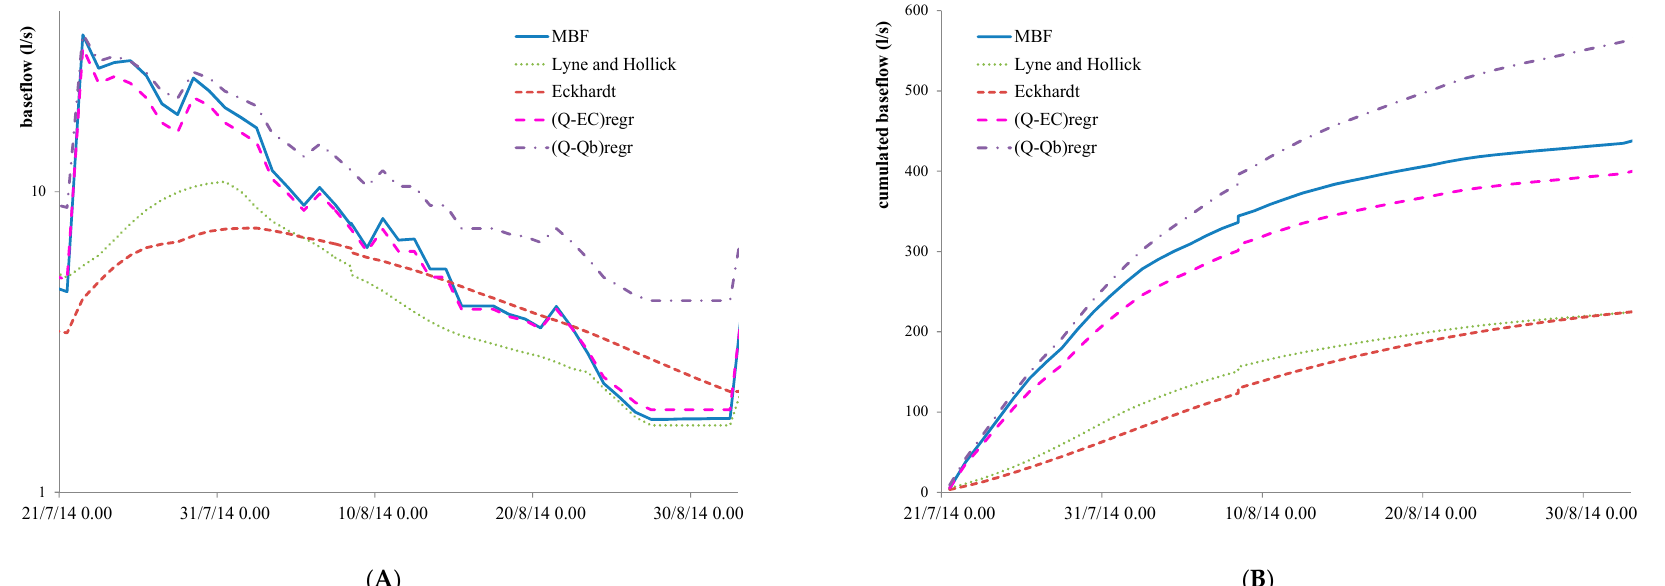
Figure 4. Comparison of baseflow patterns ( A ) and cumulated baseflow ( B ) at Ciciriello catchment, for the period from 21 July 2014 to 2 September 2014.